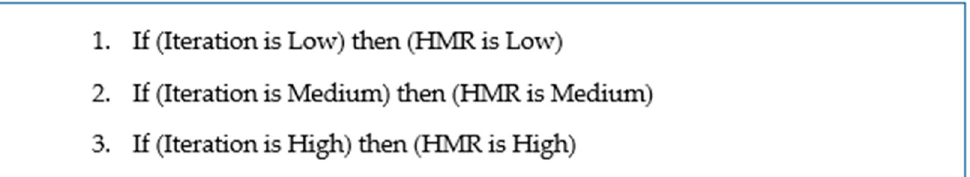
Figure 8. Rules for Fuzzy System 1 to Increase (FHS1).